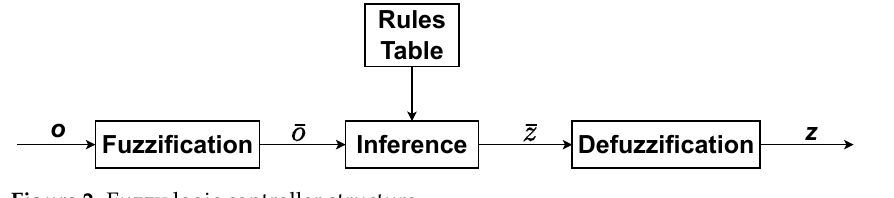
Figure 2. Fuzzy logic controller